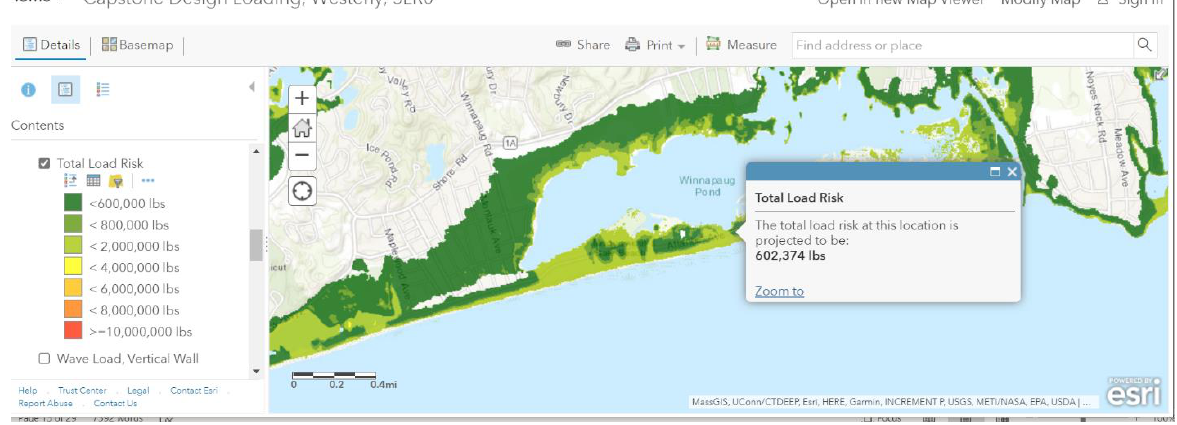
Figure 15. Use of SDL interrogation function to determine debris load (lbs/ft) ( upper panel) and total load risk (lbs/ft) ( lower panel) at a selected location of interest.